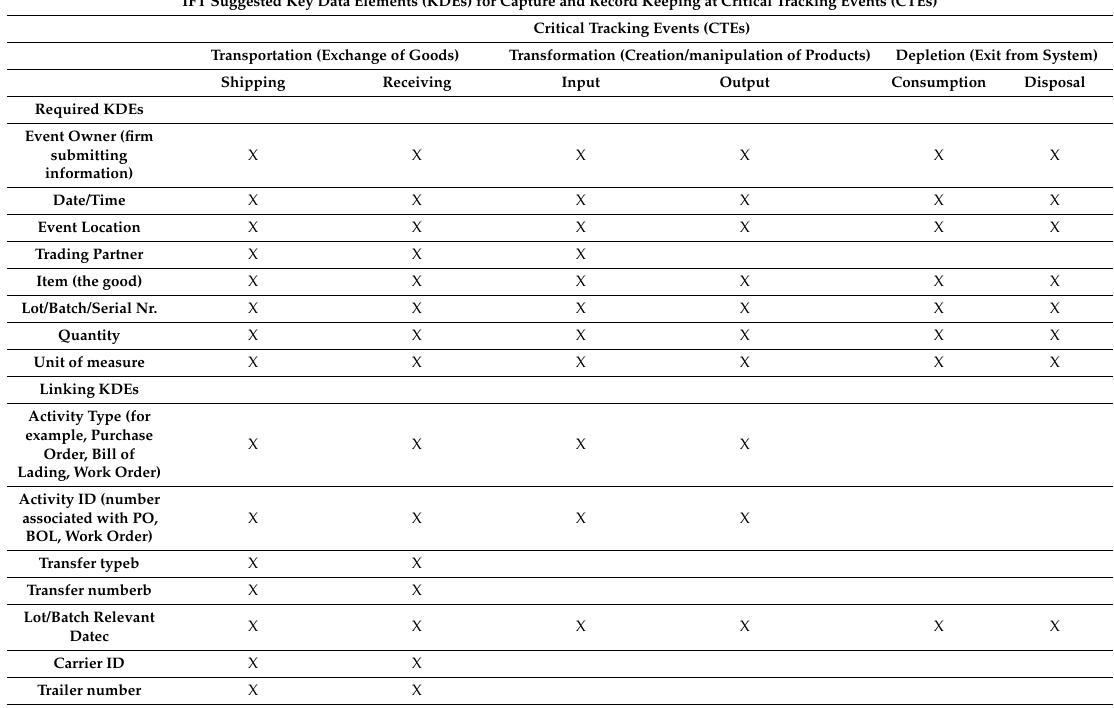
Table 2. Typical Critical Tracking Events (CTE) and corresponding Key Data Elements (KDE) for food supply chain families (adapted from